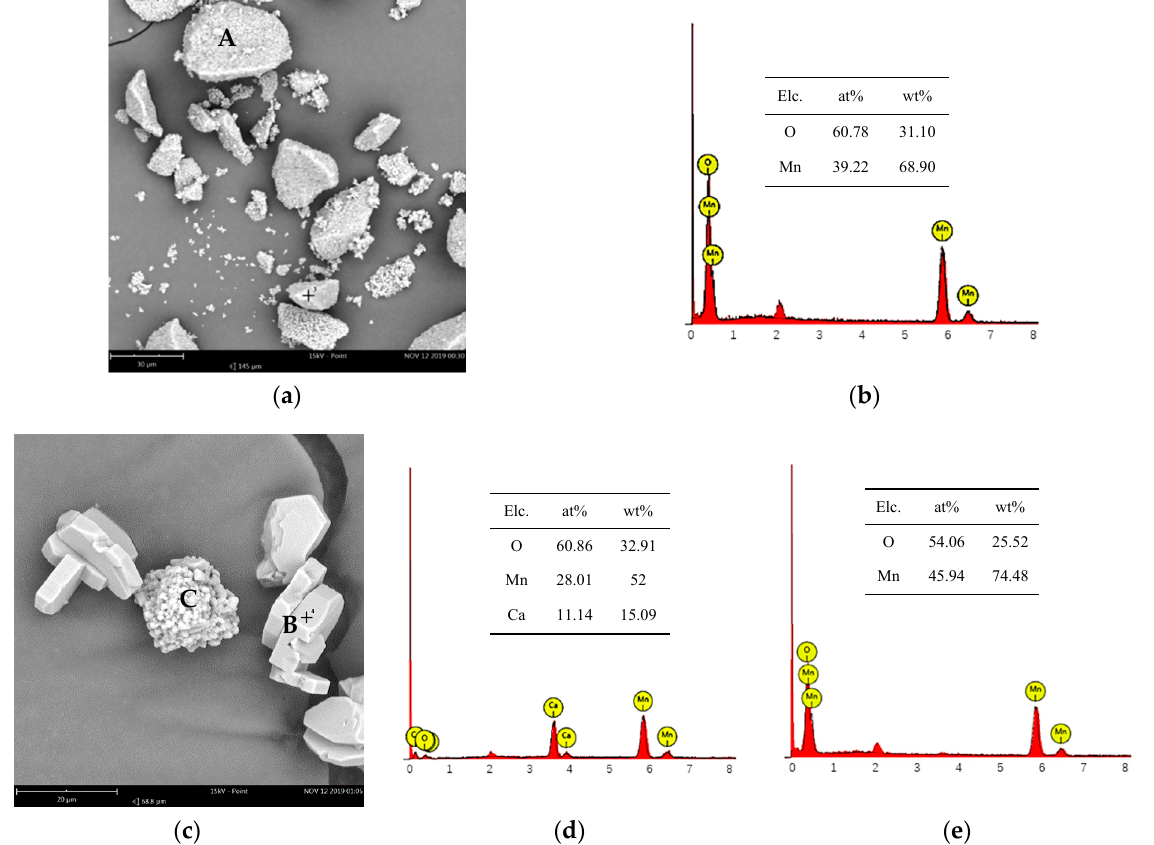
Figure 11. Raw material and product analysis ( a ) Raw material; ( b ) EDS of point A; ( c ) the product of 0.5 V electrolysis for 1 h; ( d ) EDS of point B; ( e ) EDS of point C.